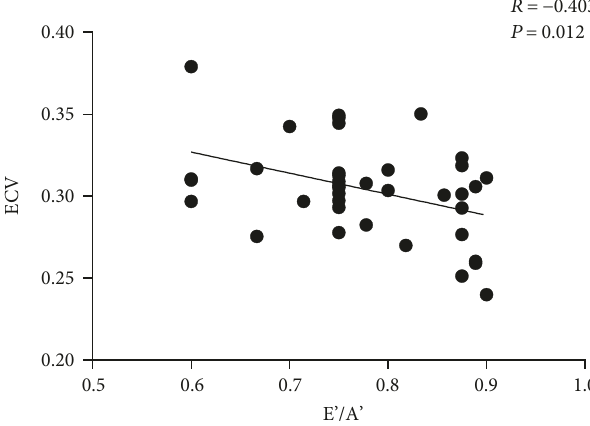
Figure 5: Relationship between ECV and left-ventricular TDI E ’ /A ’